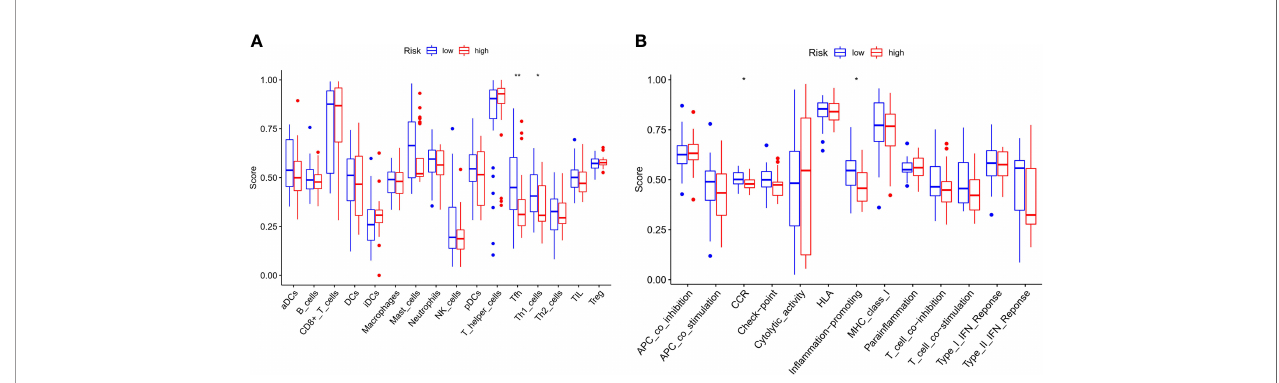
FIGURE 9 | Comparison of the ssGSEA scores for immune cells and immune pathways. (A) Comparison of the enrichment score s of 16 types of immune cells between low- (blue box) and high-risk (red box) group in the GEO cohort. (B) Comparison of the and 13 immune-related pathways between low- (blue box) and high-risk (red box) group in the GEO cohort. P values were showed as: ns not signi fi cant; *P < 0.05; **P